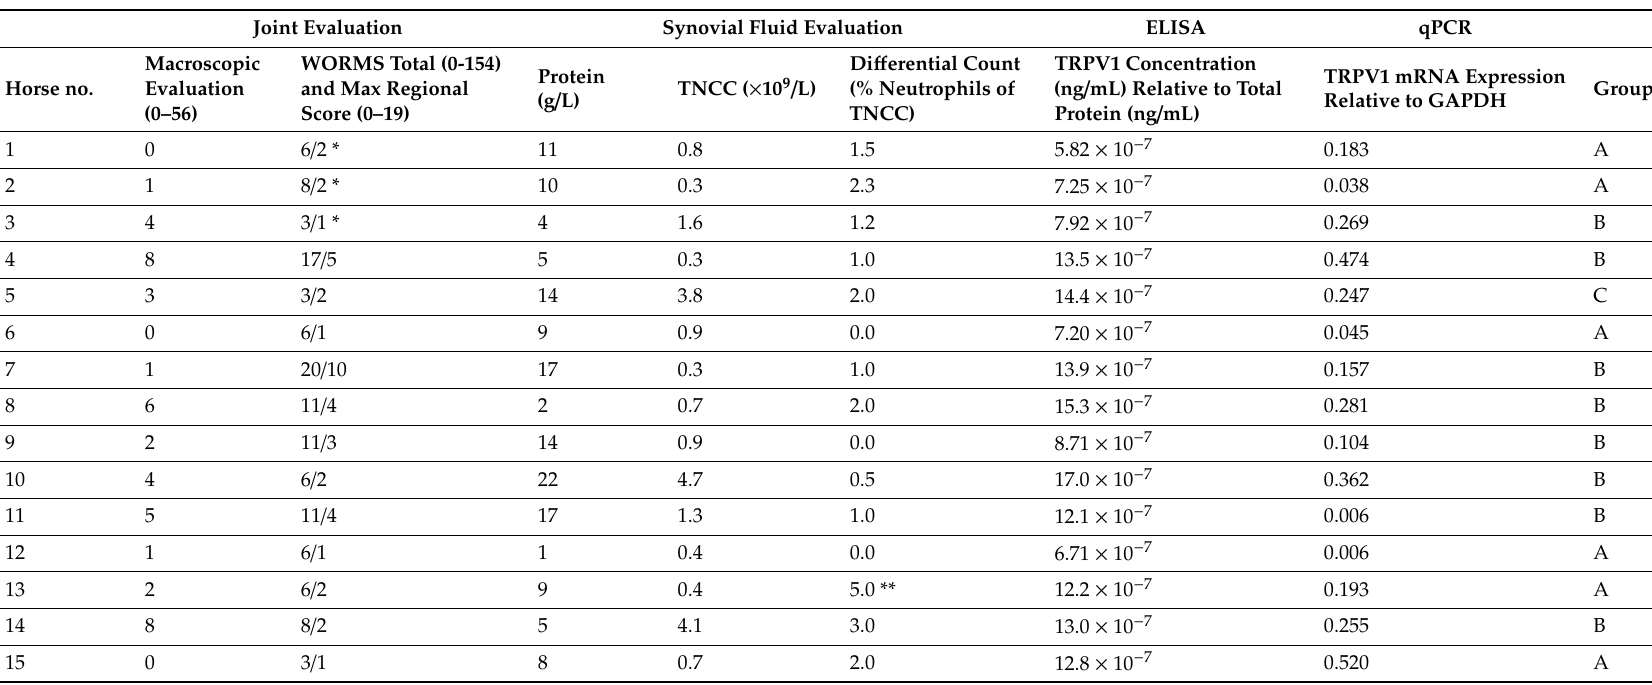
Table A1. Combined results from synovial fluid analysis, WORMS score and macroscopic evaluation of the metacarpo / metatarsophalangeal joints. Joint Evaluation Synovial Fluid Evaluation ELISA qPCR Horse